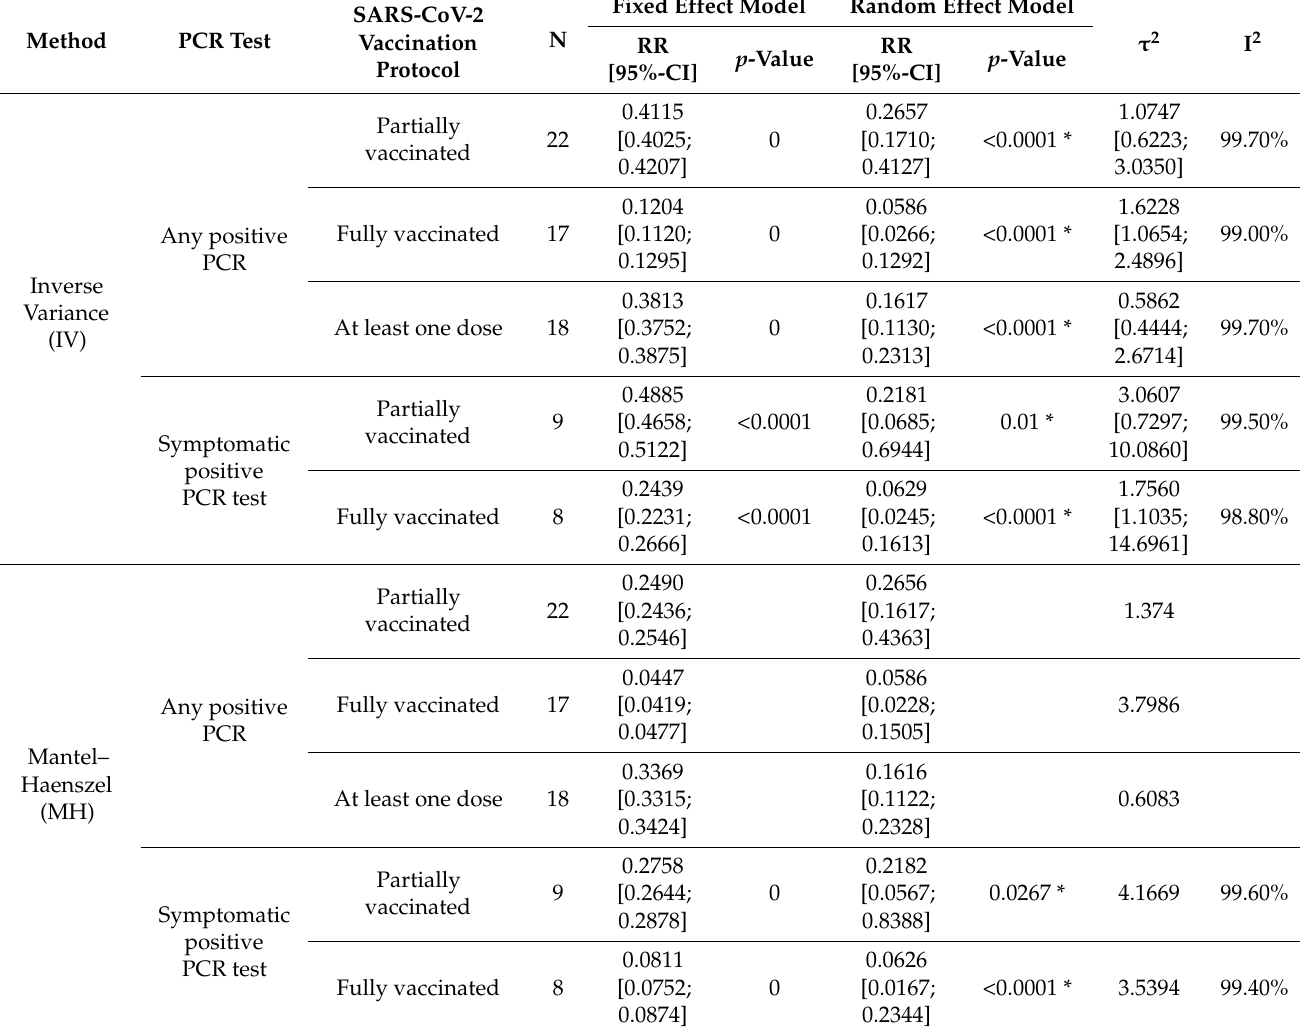
Table 1. Meta-analyses: relative risk of SARS-CoV-2 on positive PCR test after vaccination. Fixed (FE) and Random Effect (RE), inverse variance method (IV) and Mantel–Haenszel (MH) method. RR of any positive PCR and symptomatic positive PCR after SARS-CoV-2 vaccination. Any SARS-CoV-2 vaccination